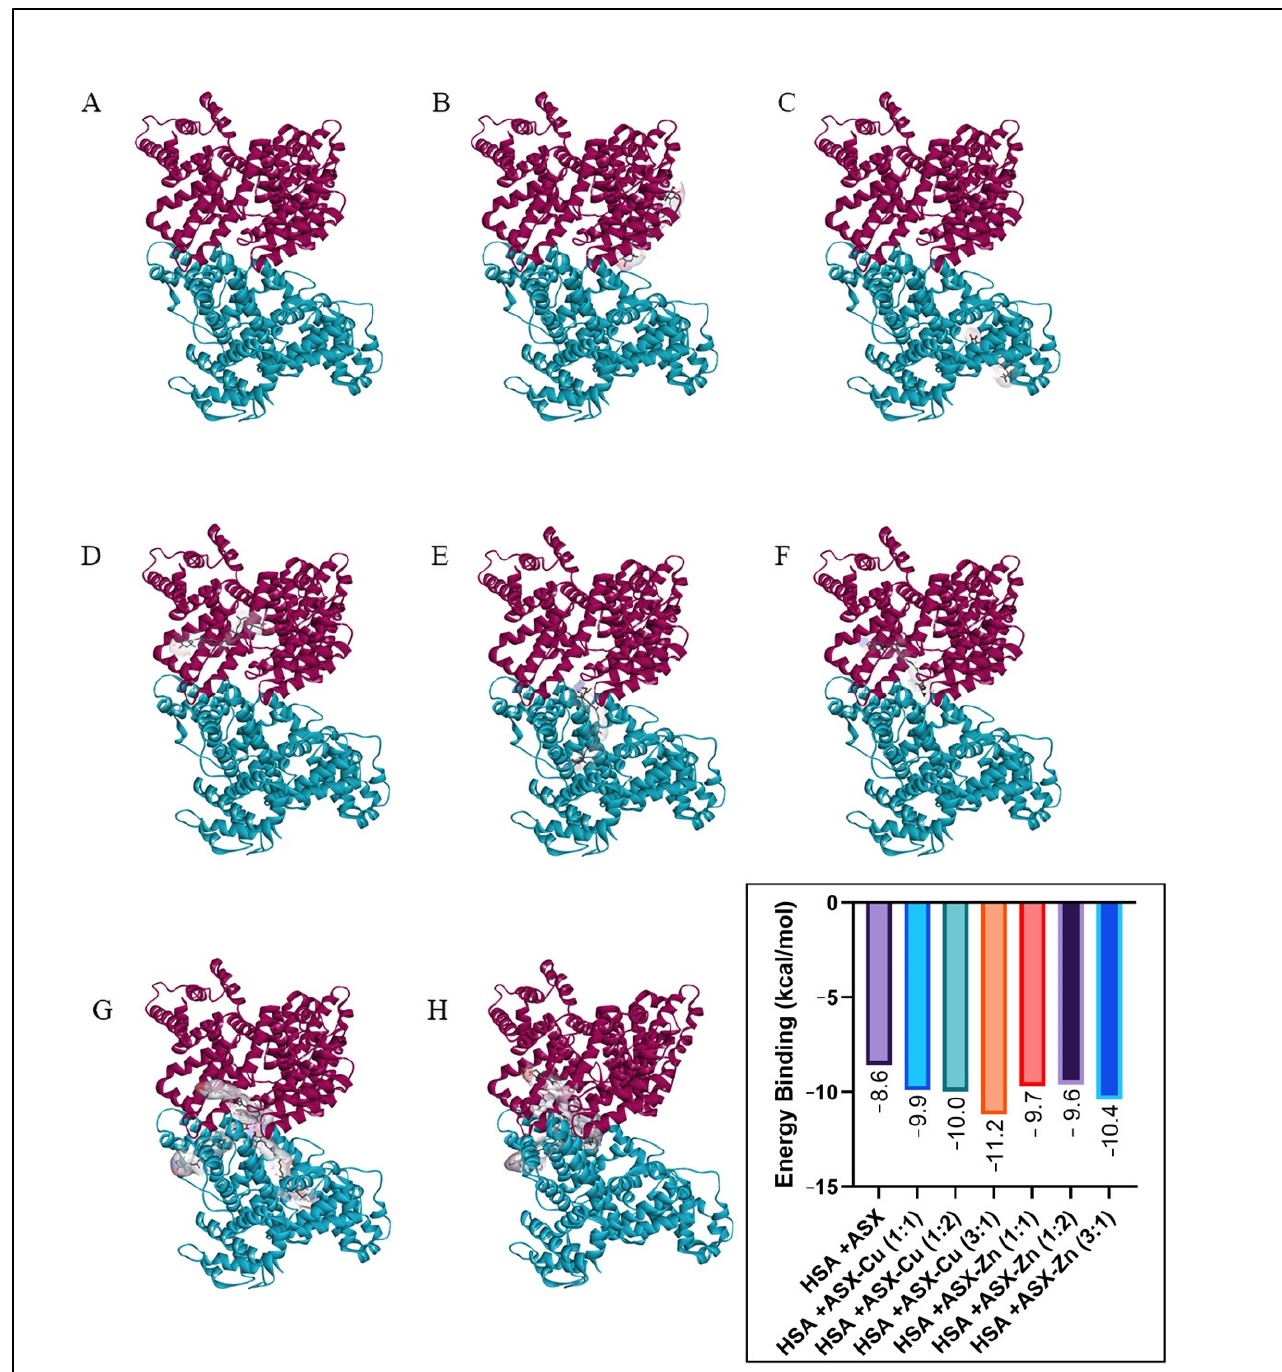
Figure 8. Docking result for ASX/ASX-metal ions with HSA: ( A ) HSA, ( B ) HSA+ASX, ( C ) HSA+ASX- Cu (1:1), ( D ) HSA+ASX-Cu (1:2), ( E ) HSA+ASX-Zn (1:1), ( F ) HSA+ASX-Zn (1:2), ( G ) HSA+ASX-Cu (3:1) and ( H ) HSA+ASX-Zn (3:1).